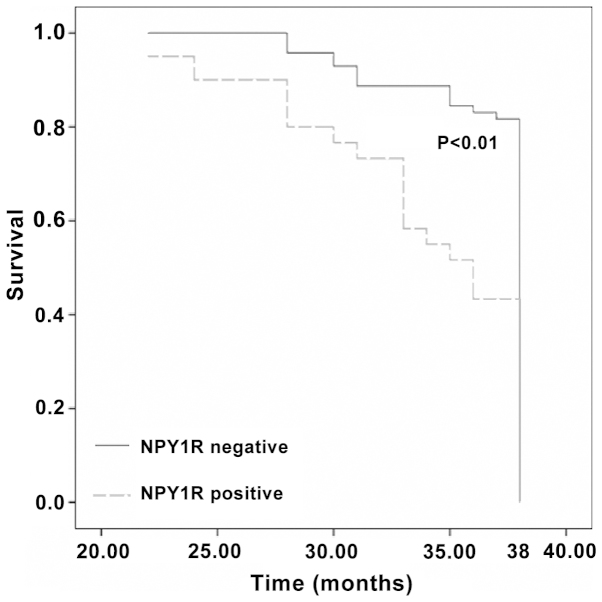
Kaplan-Meier survival analysis of breast cancer patients grouped according to neuropeptide Y receptor Y1 status (NPY1R) in the peripheral blood.